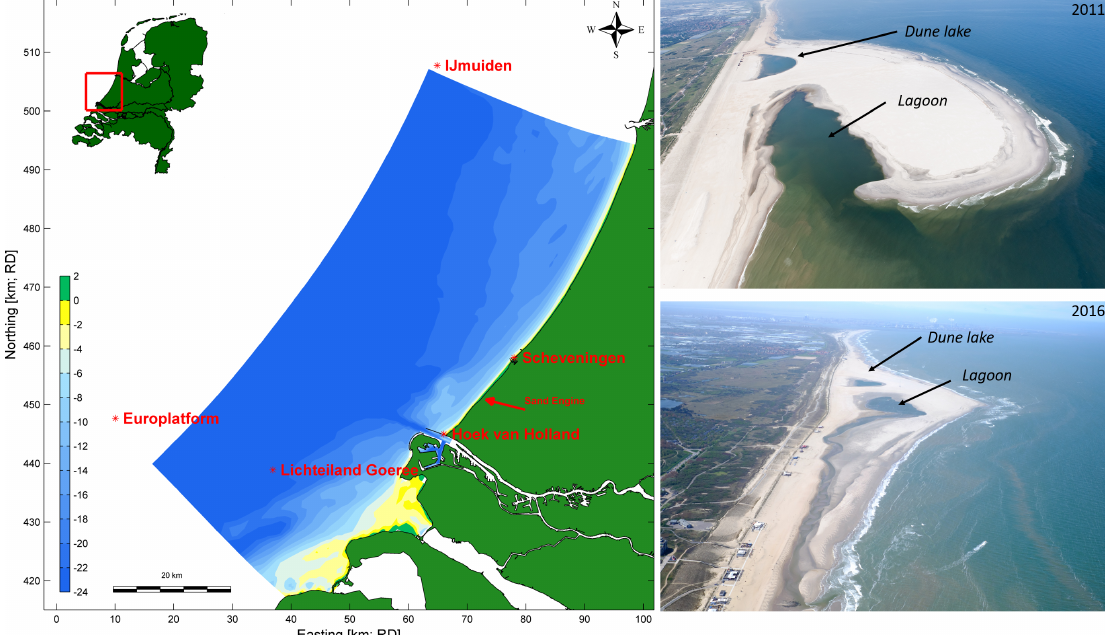
Figure 5. Geographical setting of the Delfland coast and the location of the Sand Motor ( left ). Aerial photographs from the Sand Motor in 2011 and 2016 ( right